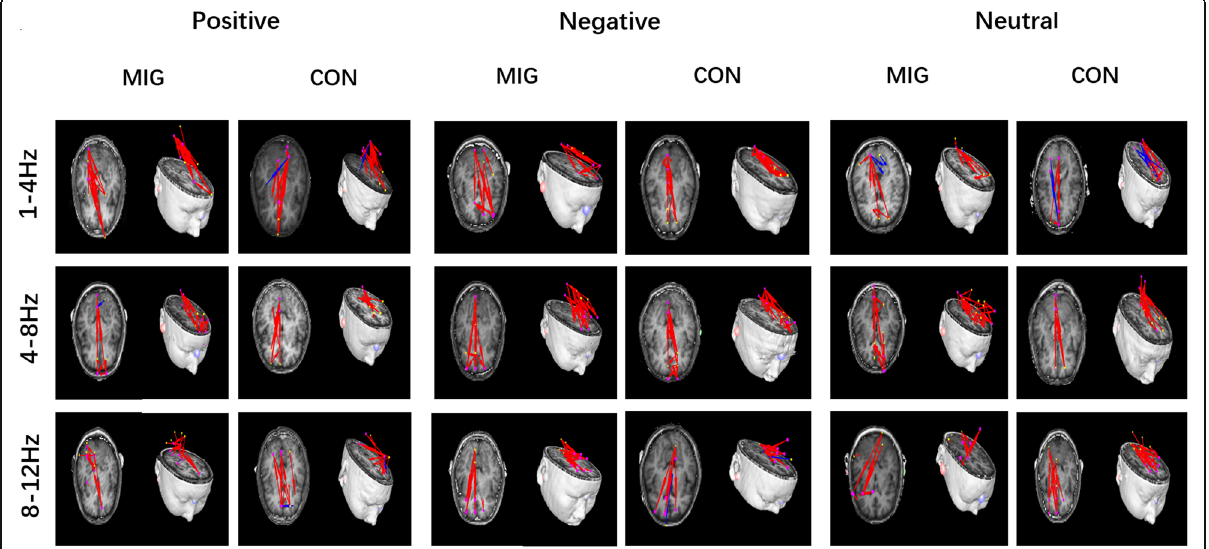
Fig. 3 Typical predominant EC networks in the 1 – 12 Hz frequency range in migraine patients and controls visualized from the axial (left column) and lateral (right column) views. No significant difference was observed between the two groups when exposed to emotional stimuli. (Colored